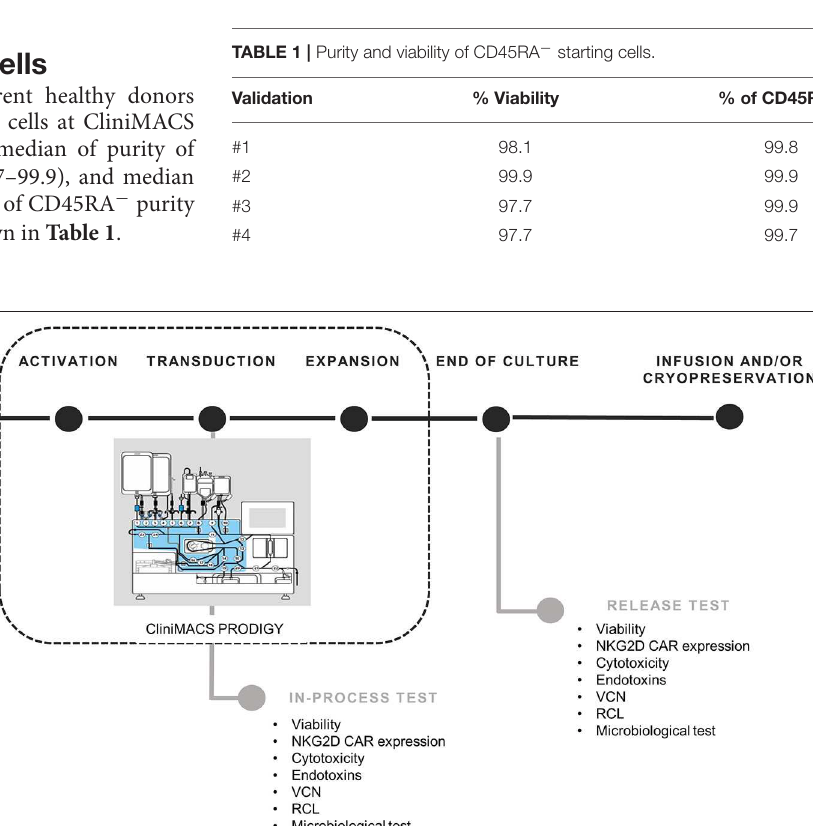
Frontiers in Immunology |